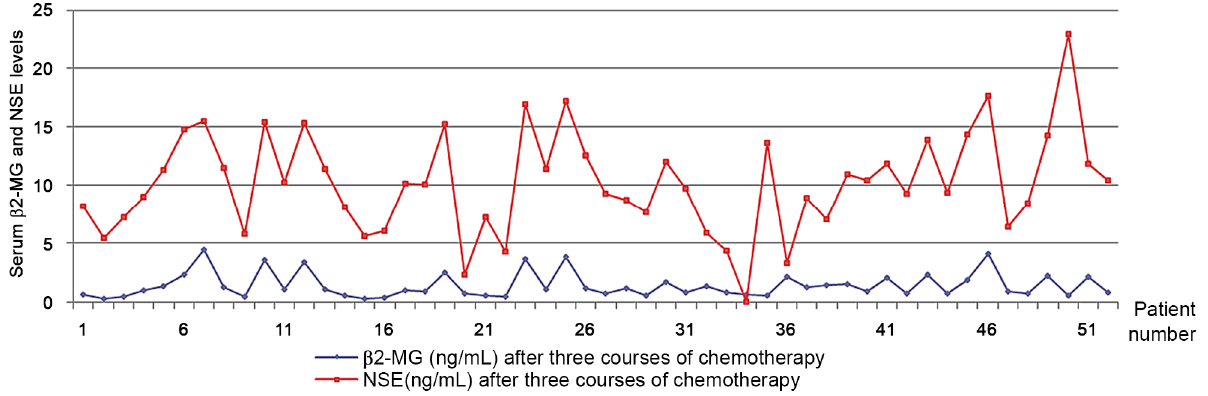
Figure 4. Correlation between NSE level and the amount of prognostic indicator b 2-MG in MM patients after receiving three courses of chemotherapy.